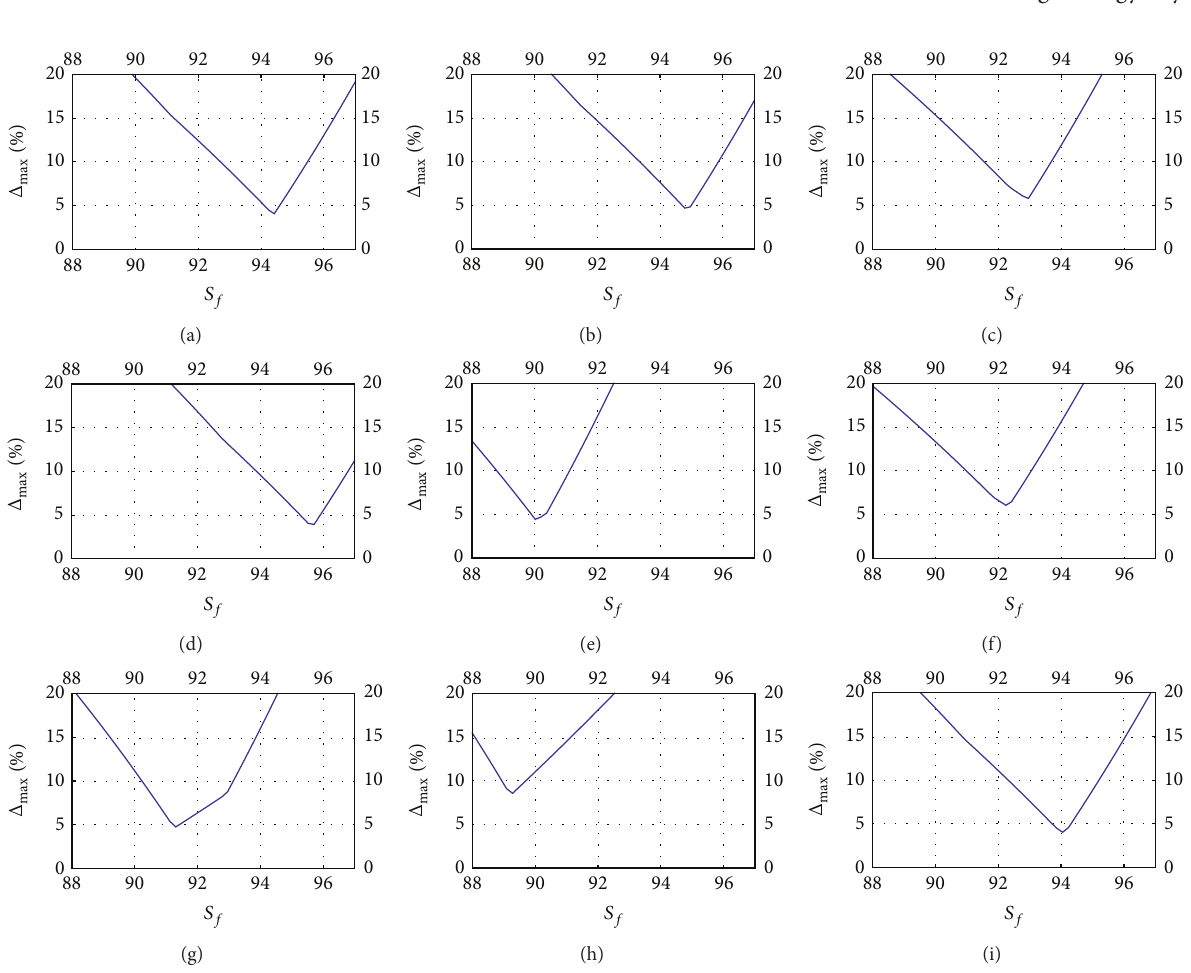
Figure 3: The behaviour of maximum deviations from the reference values of the 9 PSF involved in the 0 ] 𝛽𝛽 transitions to ground states. Subfigures (a) to (i) correspond to 𝐺 0 ] 01 to 𝐺 0 ] 09 . The horizontal axis represents the “screening factor” values, and the vertical axis represents the maximum deviations expressed in